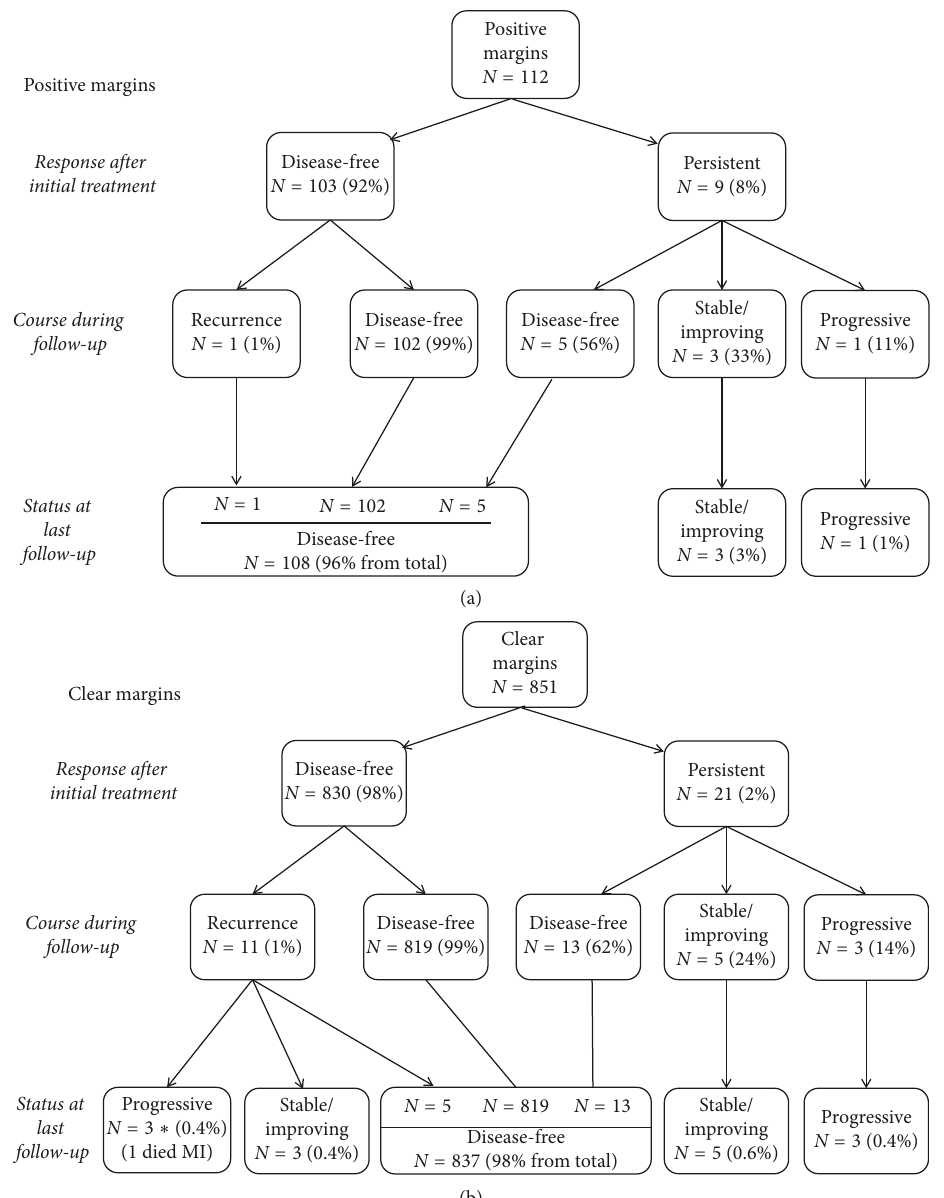
Figure 2: (a) Flow chart demonstrating the stratification of patients with positive margins after initial therapy, during follow-up, and at last follow-up. (b) Flow chart demonstrating the stratification of patients with clear margins after initial therapy, during follow-up, and at last